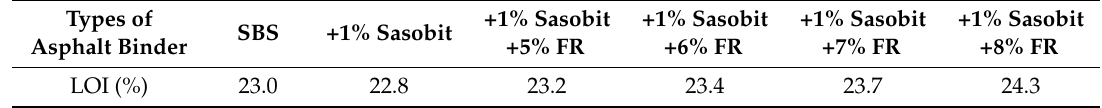
Table 3. Results of limit oxygen index test.